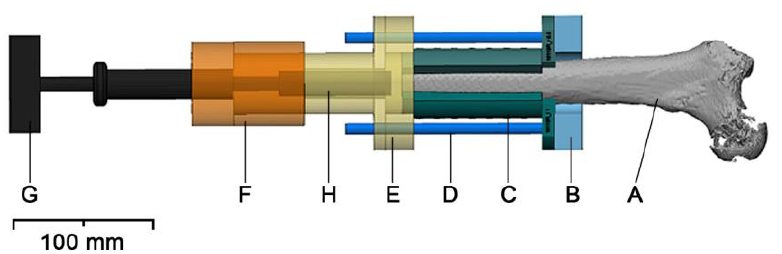
Figure 2. Experimental setup and positioning guides: The specimen (A) is mounted into a flange (B), attached to a table, with the aid of the positioning guides (C) and four steel 8 mm rods (D). The positioning guides accommodate one K-wire each. Two telescoping flanges, one (E) attached to the positioning guide and the steel rods and the other one (F) attached to the T-handle Hudson (G), allow specimen-specific alignment of the instruments and the fixture (H) insertion defined preoperatively.